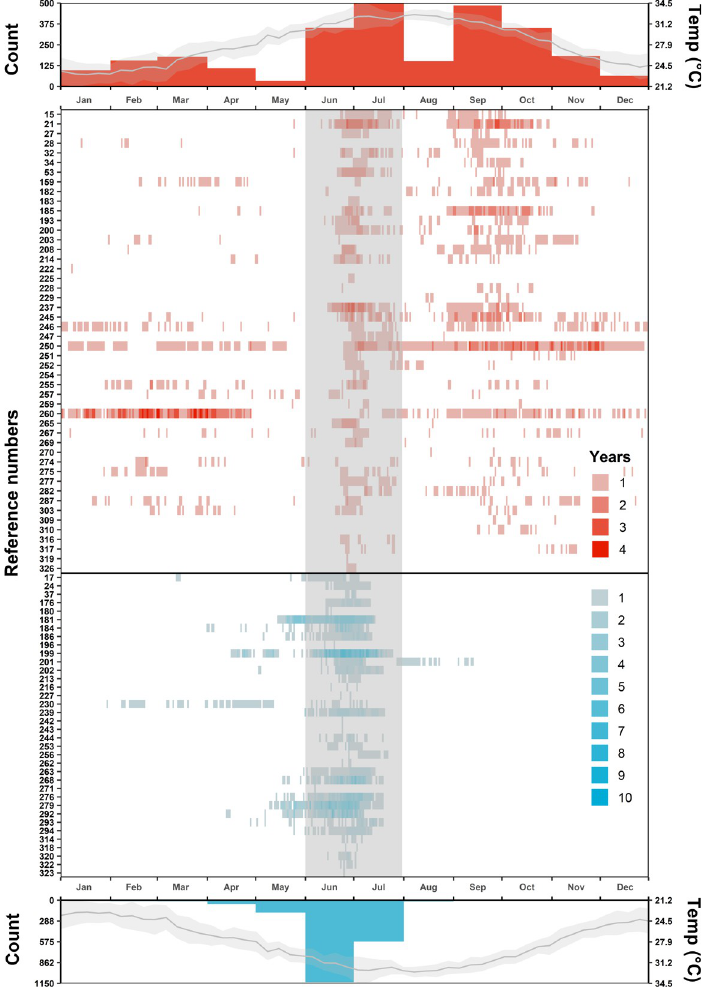
Fig 6. Monthly shark detections and water temperature on the Dry Tortugas courtship and mating ground. Acoustic detections (binned by day) with female and male sharks shown in red and blue, respectively. Detections (middle panels) are shaded darker for each year after tagging to indicate return year detections. The top and bottom histogram panels show the cumulative monthly number of daily detections across individuals for each sex. June and July are also highlighted (grey shading) in the middle panels to show when mating season occurs. Temperature lines show the mean (shading = standard deviation) maximum water temperature each week. 0.001 and 0.002, respectively). Males tended to make more frequent visits of shorter duration (median = 34 visits of 1 h on average), whereas females made fewer visits but remained on site for longer periods per visit (median = 12.5 visits of 4.4 h on average; Fig 8). The average male visit duration during the mating season never exceeded 5 hours for any individual, whereas females often averaged 5–10 hour visits and even up to two full days without an absence longer than 60 minutes (Fig 8B). Though cumulative time spent on site was not significantly different between sexes (GLMM; χ = 1.9 and p-value = 0.164), the median female spent a cumulative 2 total of 3.54 days on site during the mating season while the median male spent a cumulative total of 1.71 days on site (Fig 8C). The time between arrival and departure was also not signifi- cantly different between sexes (GLMM; χ = 0.1 and p-value = 0.730). But during the mating 2 season, females stayed on site for a median of 11.43 days before departing, whereas males stayed on site for a median of 27.14 days between arrival and departure (Fig 8D).